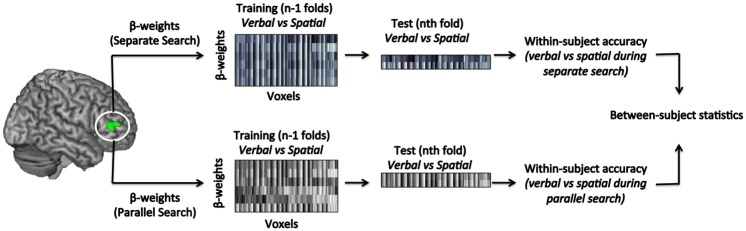
Summary of the ROI MVPA.ROIs were selected based on the contrast between the 4 rule discovery conditions (weighted +1 each) and the two control conditions (weighted -2 each). All the resulting statistical maps were corrected for multiple comparisons at the cluster level (p(corr)<0.05). The matrices of β values extracted from each ROI were partitioned in terms of rule search type, forming one multi-voxel β pattern for each search type (one for the separate search and one for the parallel search). The resulting multi-voxel β patterns were submitted to MVPA employing the standard leave-one-out cross-validation technique. Classification accuracies were then used in group-level statistical analyses.